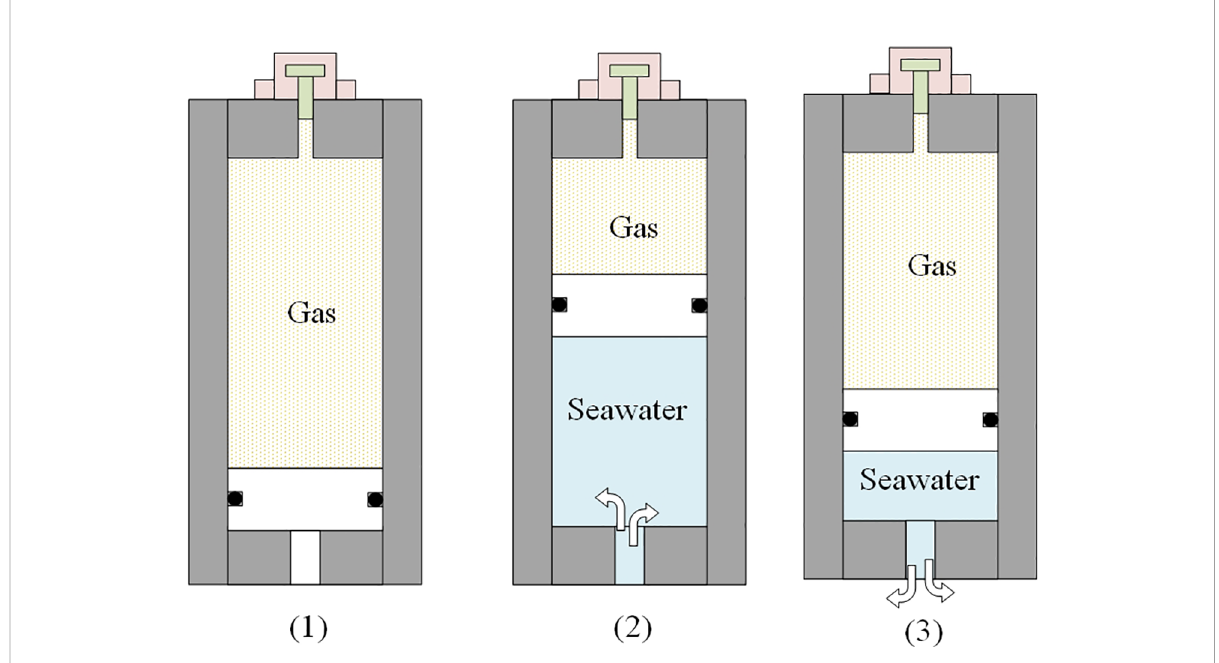
FIGURE 11 working process of a piston accumulator applied in isobaric sampling [(1): pre-charge state; (2): high pressure seawater gets into the accumulator and compresses the gas; (3): the high-pressure gas pushes some of the seawater return to the pressure